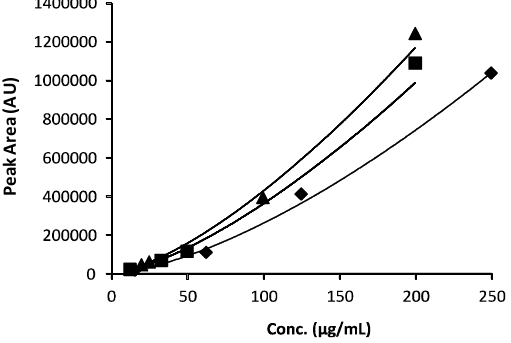
Figure 2. The calibration curves obtained for the three selected amino acids ( Leu; Phe, Trp).